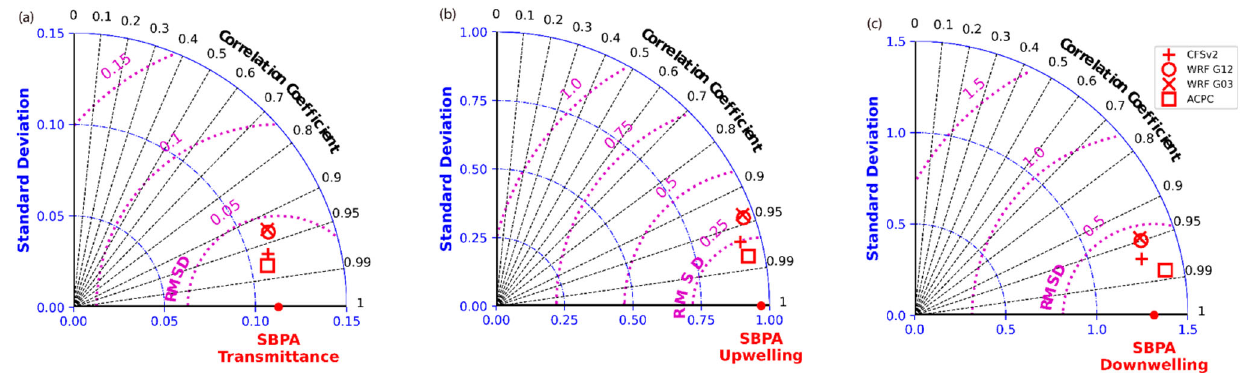
Figure 3. Taylor diagrams of ( a ) atmospheric transmittance, ( b ) upwelling radiance, and ( c ) downwelling radiance. The parameters calculated with SBPA radiosondes are the references. The black dashed lines represent the correlation coefficient (R), blue dash-dot lines represent the standard deviation, and the magenta dotted lines represent the root mean squared deviation (RMSD = RMSE).